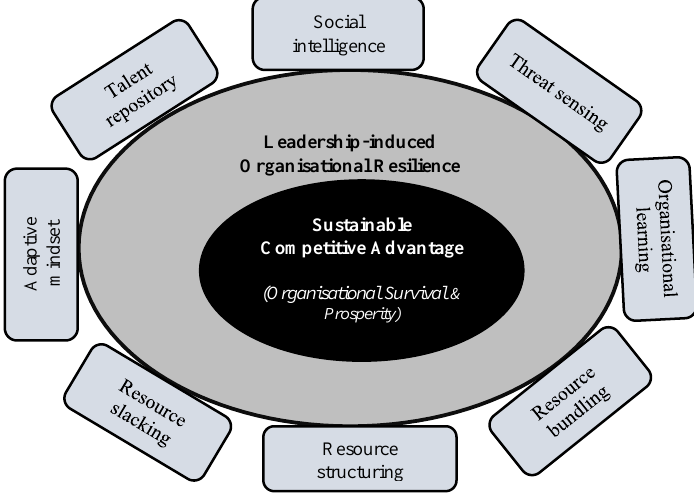
Figure 2: Organisational Resilience